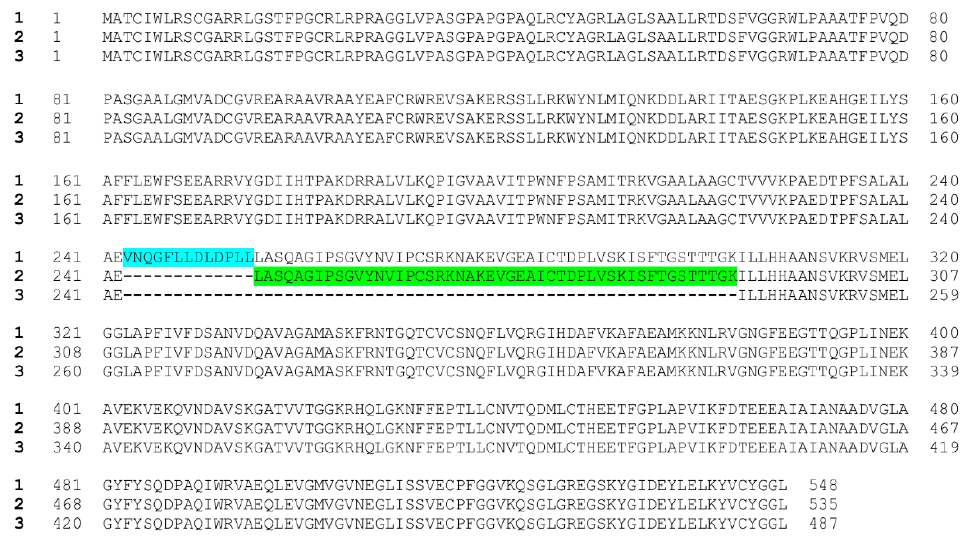
Figure 2. SSADH isoform protein sequences. Numbers to the left in bold show the isoform numbers. Blue highlight marks the 13 extra amino acids in isoform 1, whereas green highlight depicts the 48 amino acids present in isoforms 1 and 2 but missing from isoform 3.